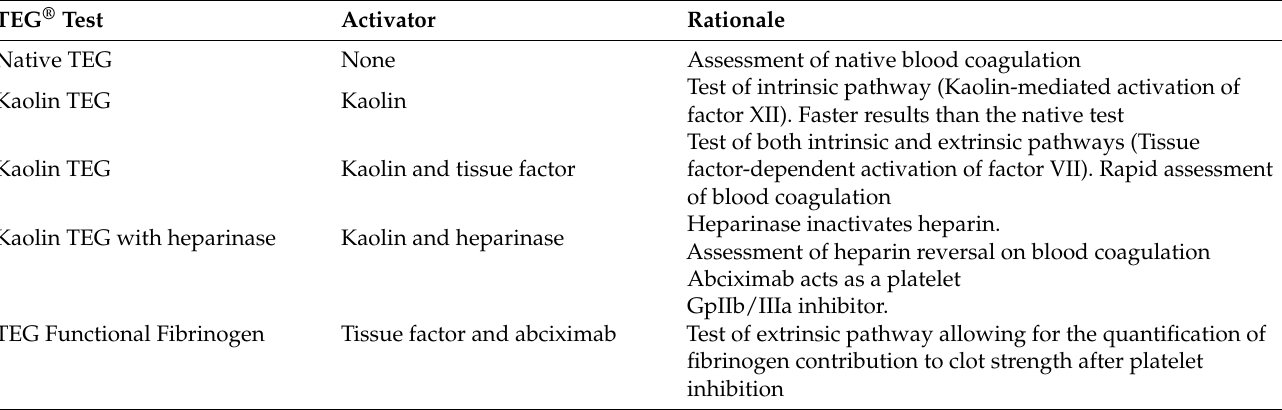
Table 2. Commercially available TEG ® assays.